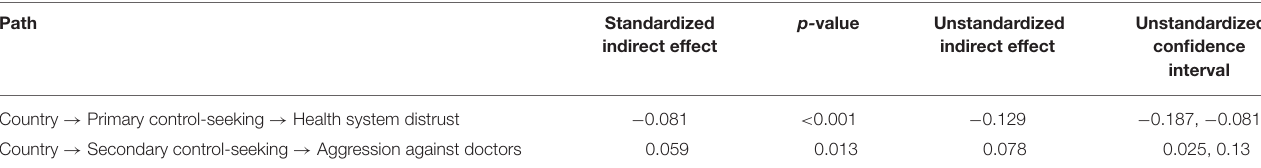
TABLE 5 | Analyses of indirect effects for the general healthcare uncertainty scenarios (Study 2).